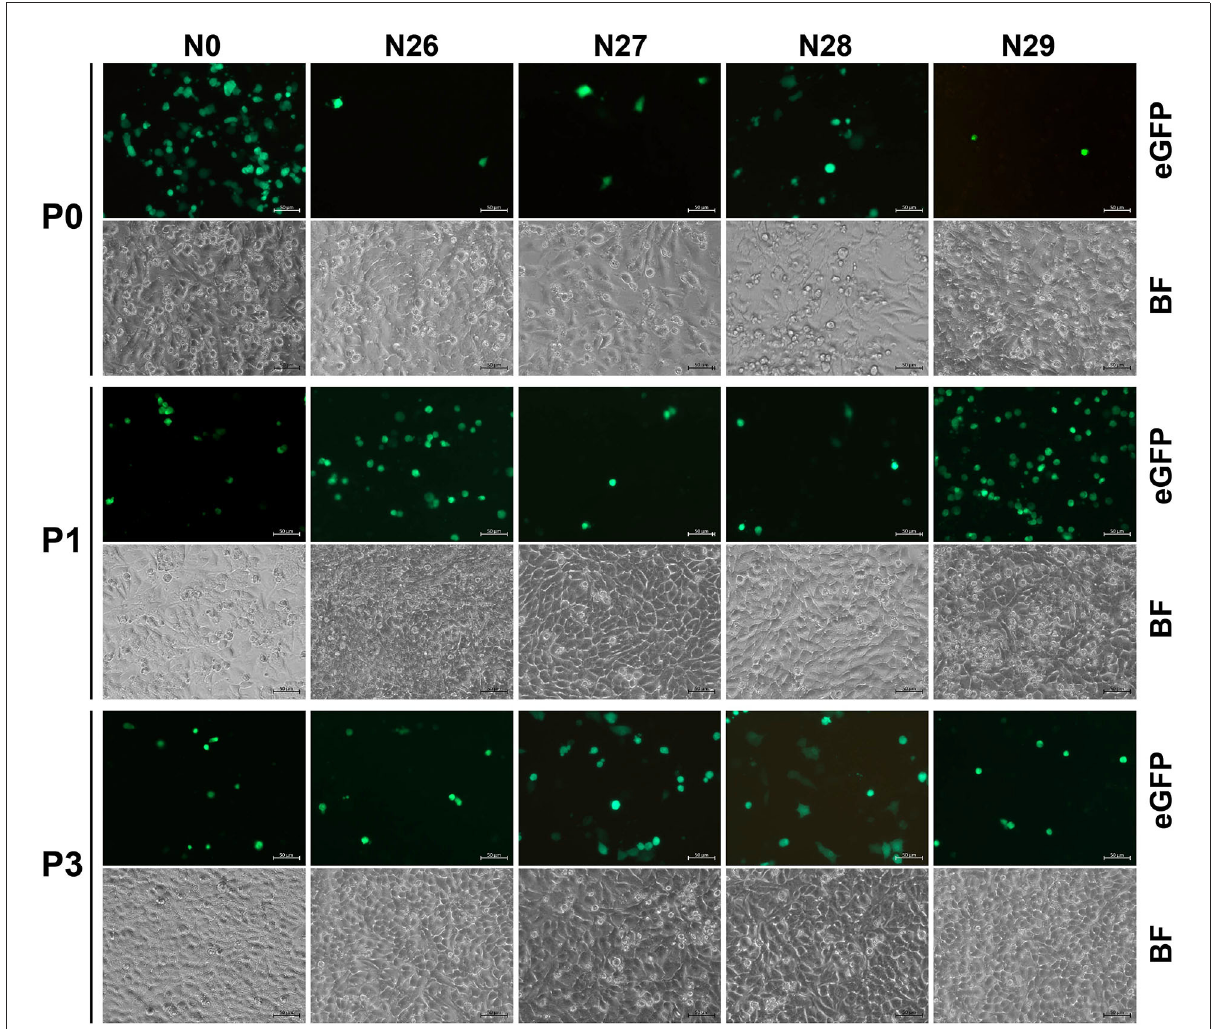
FIGURE4 Rescue and passaging of rSVA-N26 to -N29, and -N0. Green fluorescence is visible on cell monolayers during serial blind passaging. BF, bright field. P0: passage-0 at 72 hpt. P1 and P3: passage-1 and − 3 at 48 hpi. Bar = 50 µ m.